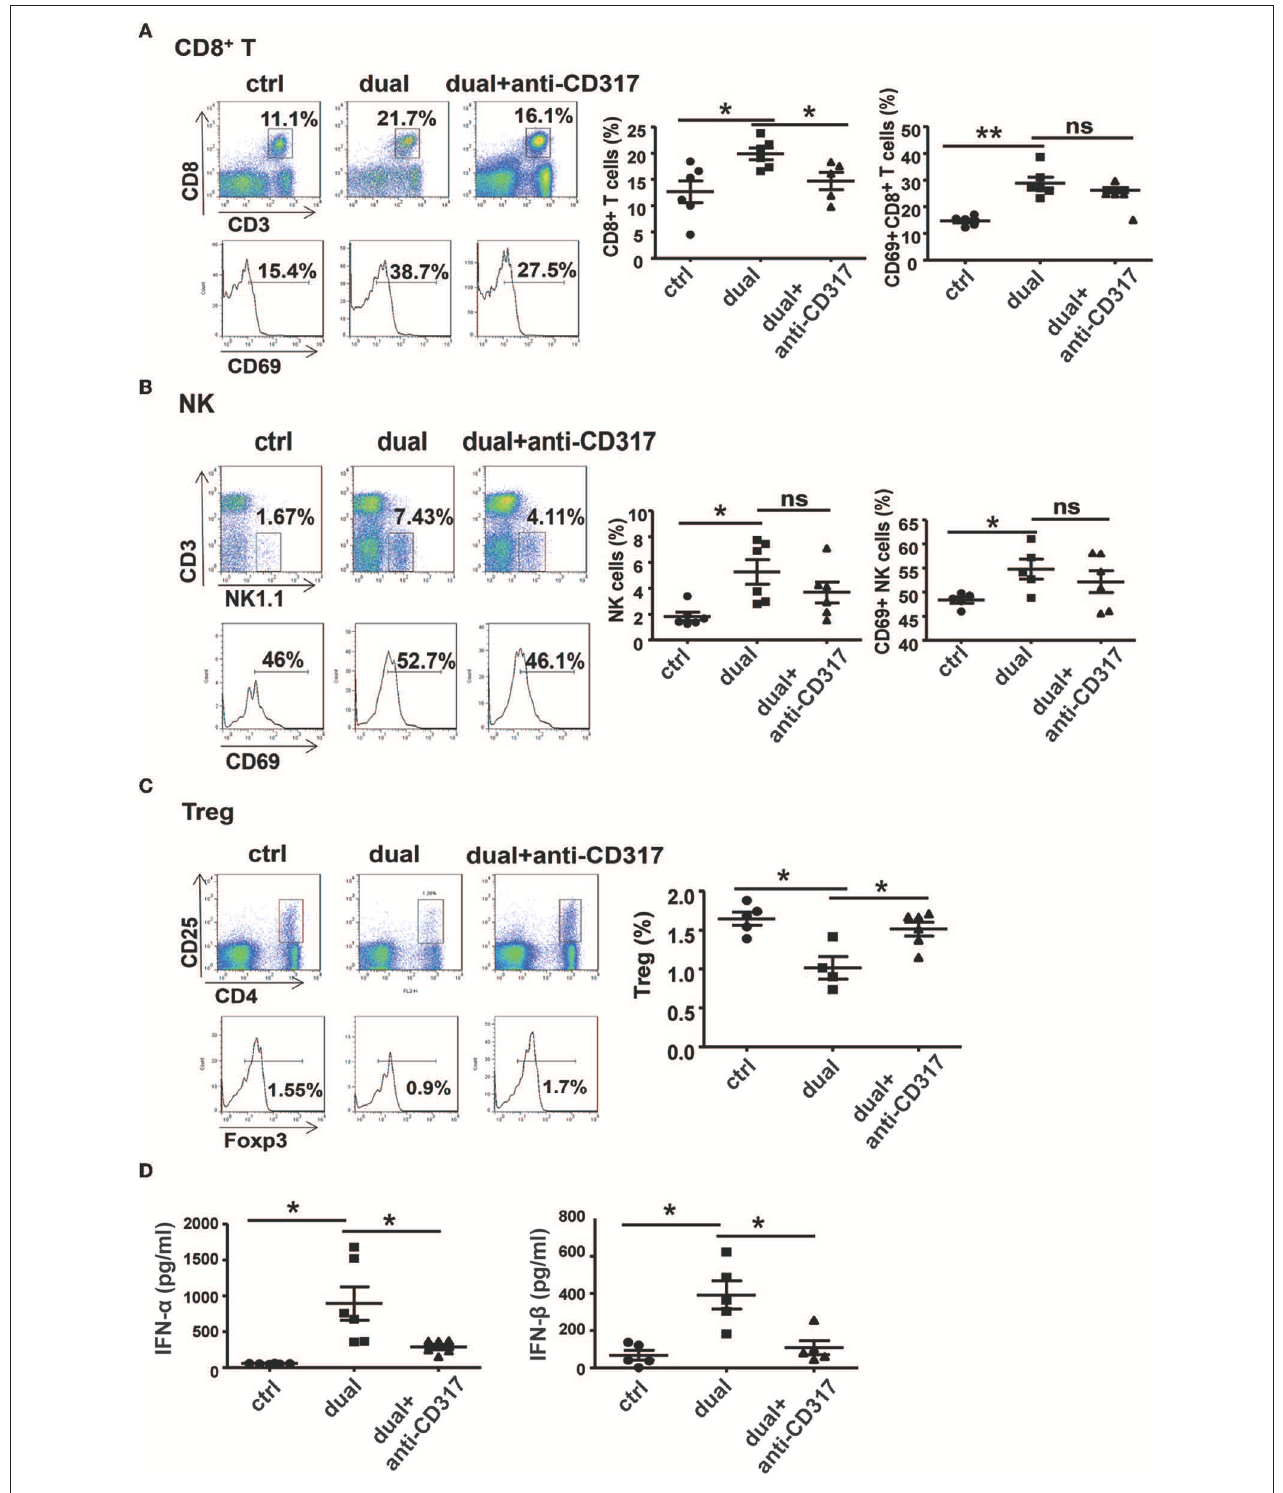
FIGURE 6 | pDCs are necessary for the activation of NK cells and CD8 + T cells in vivo . The percentages and activation of CD8 + T cells (A) , NK cells (B) , and Treg cells (C) in tumor tissues after pDC depletion were determined by flow cytometric analysis. (D) Serum levels of IFN- α and IFN- β were detected by ELISA after pDC depletion. Data are representative of three independent experiments. ** P < 0.01 or * P < 0.05 vs. control group. pDCs, plasmacytoid dendritic cells; NK, natural killer; Treg, regulatory T cell; IFN, interferon.